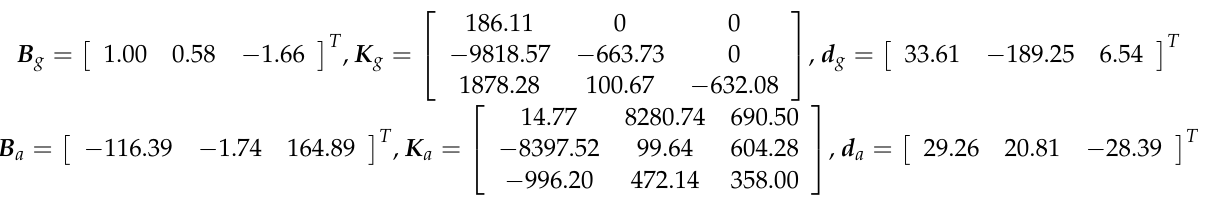
Figure 12. The estimated results of nonlinear error items. Based on Figure 12, it can be seen that the nonlinear error coefficients all converged to a stable value at the end of the calibration experiment. The nonlinear error coefficients of the X axial ACC, Y axial ACC, and Z axial ACC are 29.26 × 10 − 6 s/m 2 , 20.81 × 10 − 6 s/m 2 and − 28.39 × 10 − 6 s/m 2 , respectively. The nonlinear error coefficients of the X axial FOG, Y axial FOG and Z axial FOG are 33.61 × 10 − 6 s/rad, − 189.25 × 10 − 6 s/rad and 6.54 × 10 − 6 s/rad, respectively. The recognition results of all the error items are listed below. With the error coefficients, the nonlinear error model could be established. Thus, the error items could be